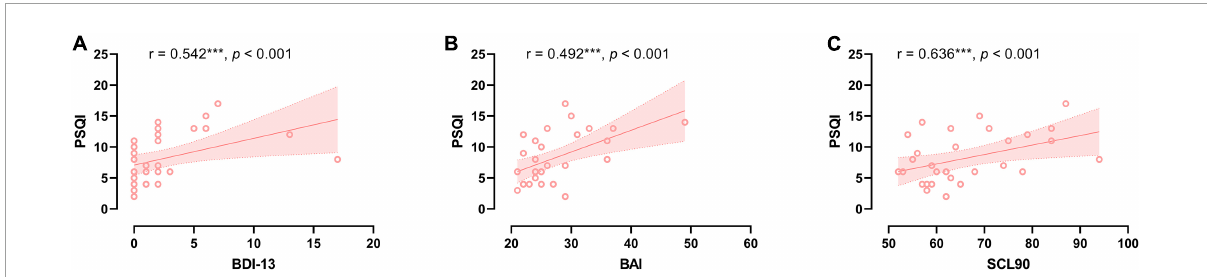
FIGURE1 The relationship between sleep quality and neuropsychological severity in CSVD group. (A) Correlation between sleep quality and depression severity. (B) Correlation between sleep quality and anxiety severity. (C) Correlation between sleep quality and SCL90 score.